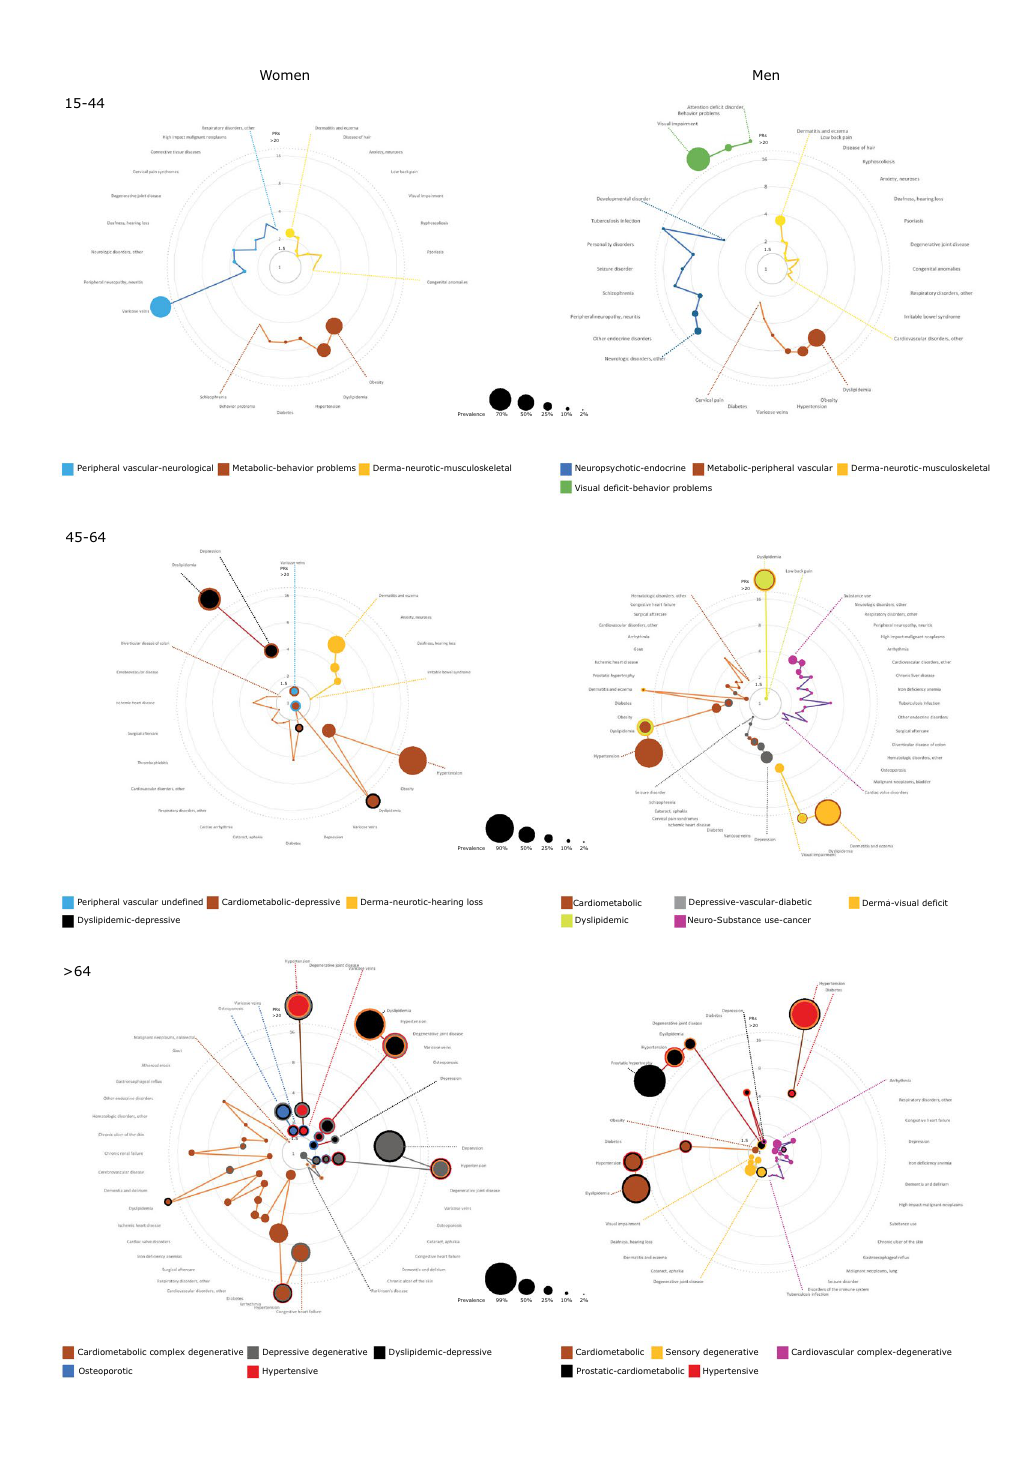
Figure 2. Disease composition of the multimorbidity clusters identified in the study population based on sex and age, according to prevalence ((P); proportional to node size) and prevalence ratios (PRs, we used the lowest PR for each disease). Each cluster has a color, if a node (disease) has more than one color, that disease is included in other